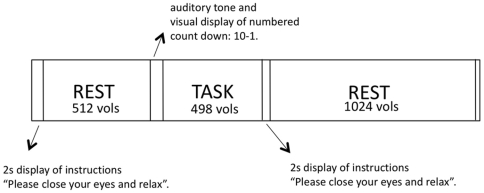
Summary of experimental paradigm.